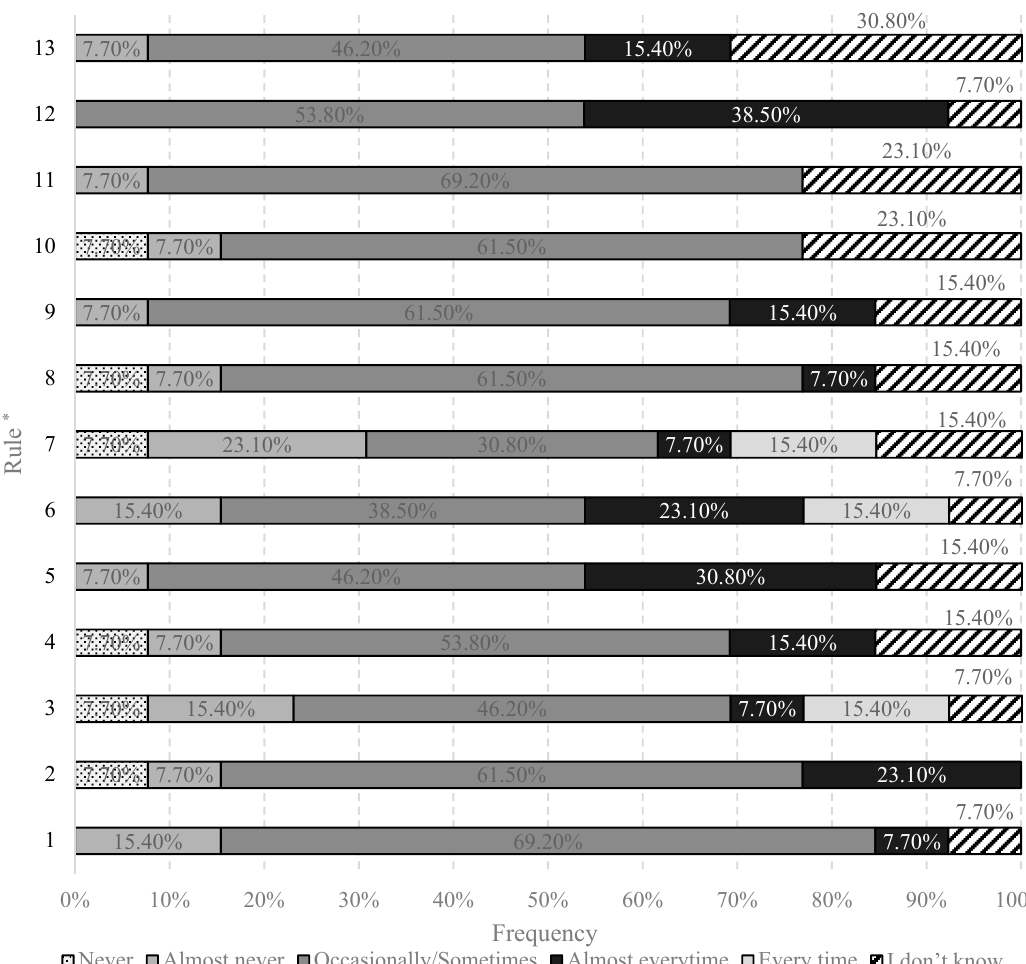
Figure 9. Diverging bar chart for the frequency of association among HVAC common faults. * Check Figure 7 for the rules.